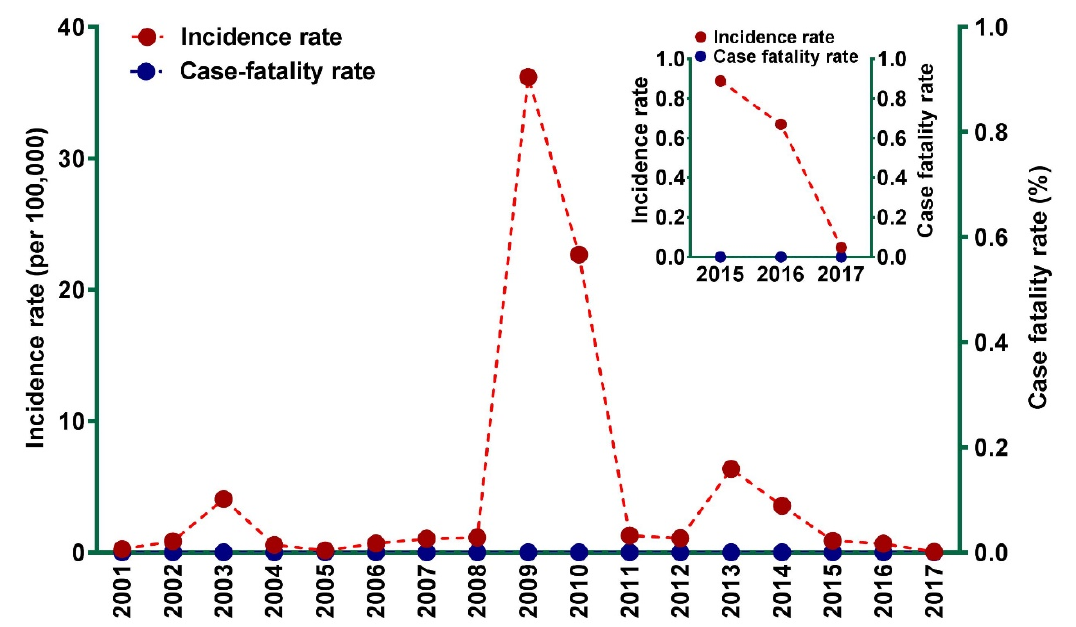
Figure 1. Incidence rate and case fatality rate of chikungunya between 2001 and 2017 in Indonesia. The insert shows details of reduction of chikungunya incidence rate in 2017.